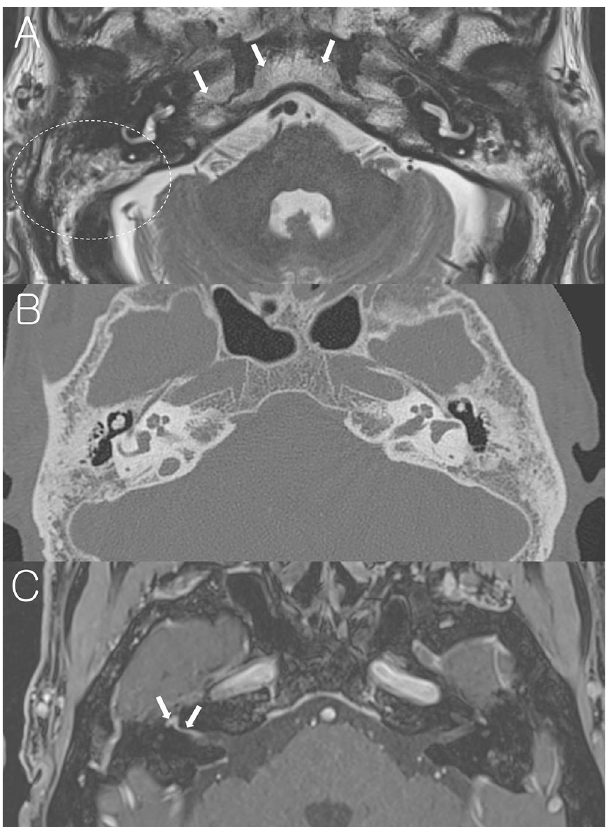
Figure 3. A representative case of Bell’s palsy with sclerotic mastoid. ( A ) Non-contrast axial T2-weighted image at the level of IAC shows heterogeneous high signal intensity in the mastoids (dotted circle) which have similar signal intensity from the adjacent clivus and petrous apex (arrows), suggesting bony sclerotic change. ( B ) Temporal bone CT confirms bony sclerotic change and decreased number of mastoid air cells. ( C ) Post-contrast axial T1-weighted image at the Bill’s bar shows enhancement of the distal canalicular, labyrinthine, genu and proximal tympanic segment of the right facial nerve (arrows).